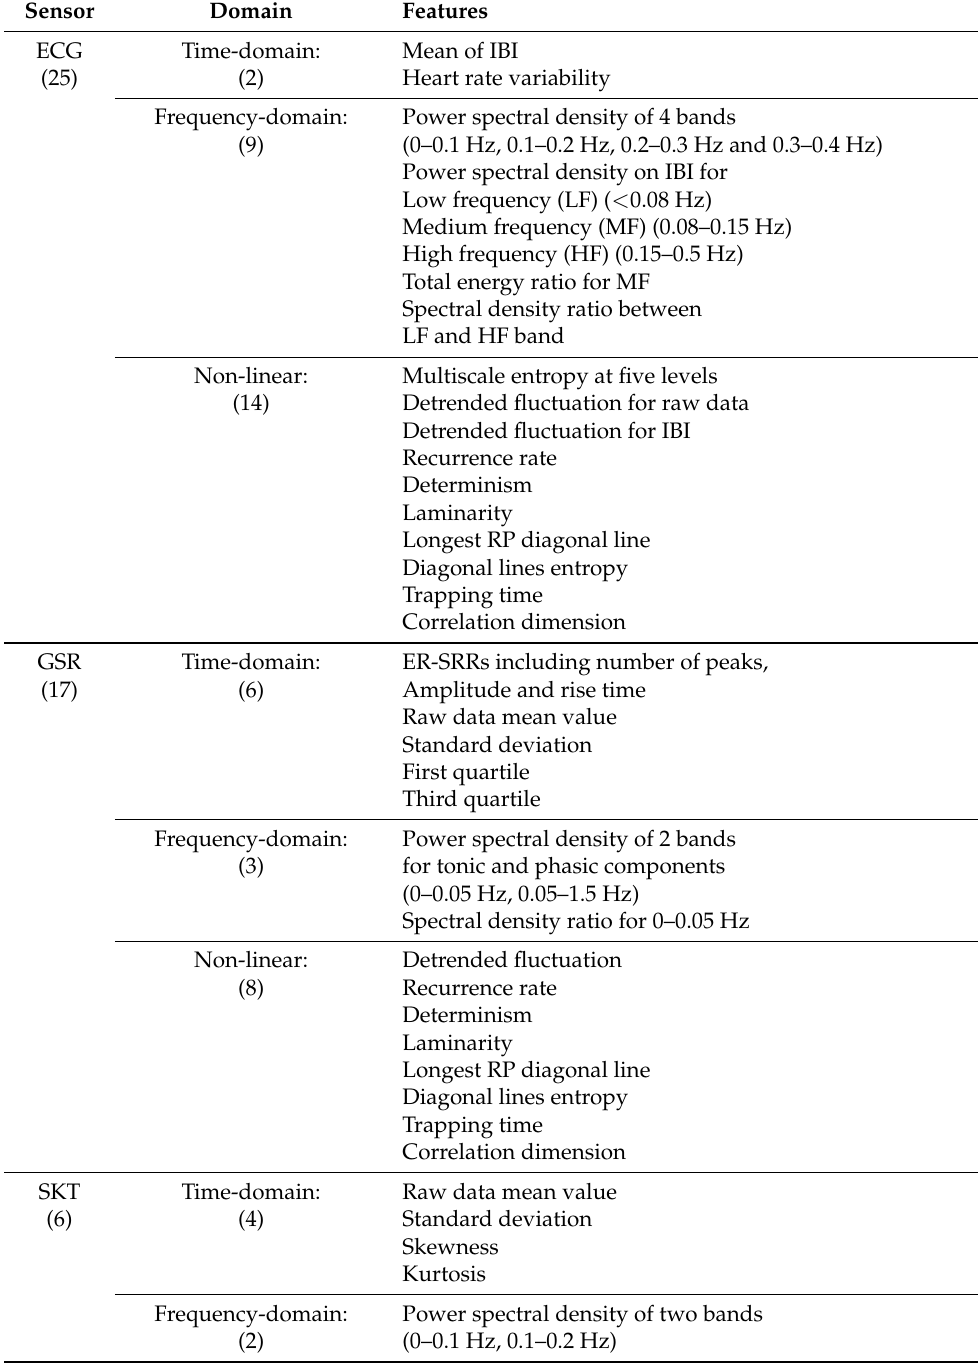
Table 1. Features extracted for the proposed wearable-ready fear recognition system. IBI: inter-beat interval; RP: recurrence